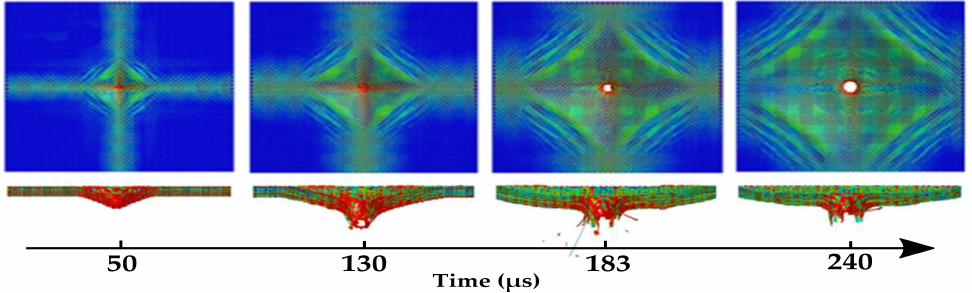
Figure 4. Visual aspect of the cross strain and pyramidal elevation due to stressed yarns and inter- yarn friction of a Kevlar fabric during ballistic impact. Adapted with permission from Ref. [105]. Copyright 2015, Elsevier.